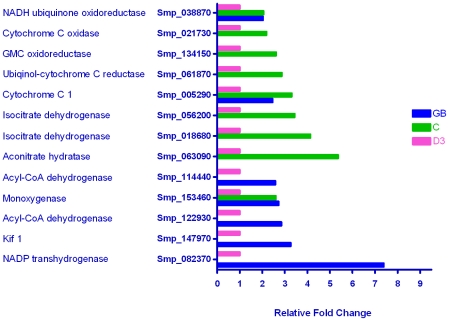
Genes whose products are involved in aerobic metabolism.The relative expression levels of the thirteen differentially expressed genes encoding proteins involved in aerobic metabolism are shown. The majority (9/13) were up-regulated in the cercaria, with 7 in the germ ball, and none in the day 3 schistosomulum. This reflects the intensive energy requirements of the rapidly swimming cercaria.